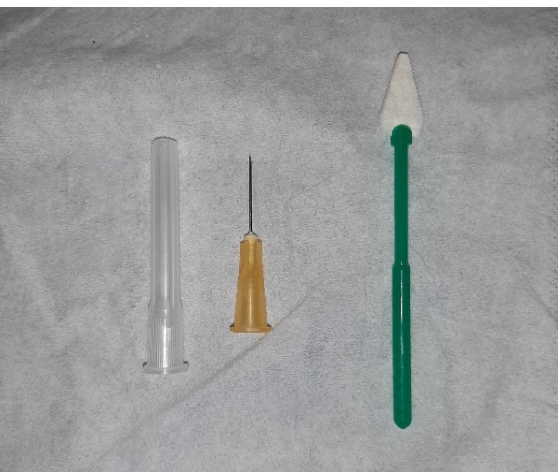
Figure 1. Examination set: intradermal needle and sterile triangular hemostatic suction sponge.